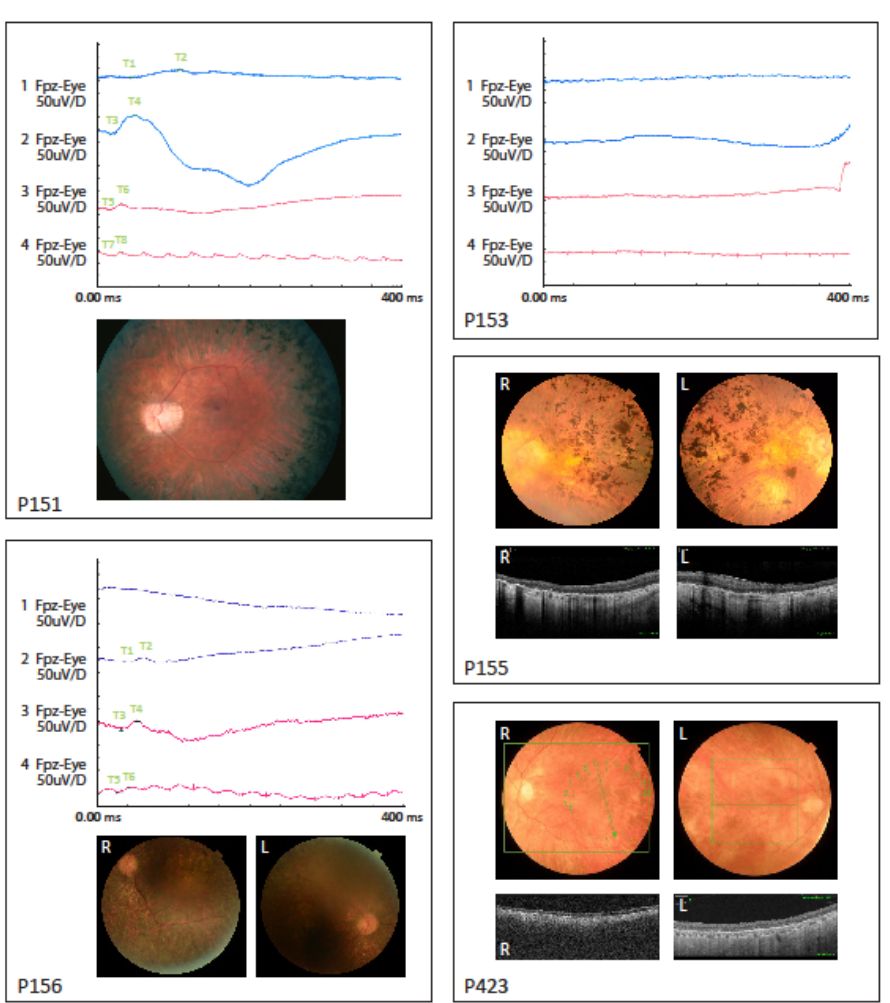
Figure 1. Electroretinograms (ERG) data shown for P151, P153 and P156. Fundus pictures shown for P151, P155, P156 and P423. OCT pictures for P155 and P423. Descriptions of data are listed in Table 1.